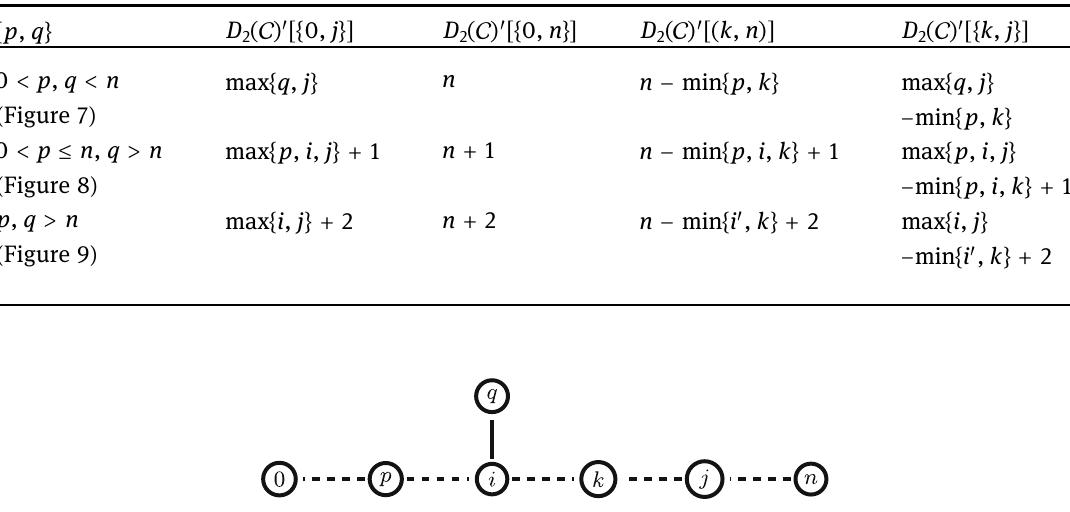
Figure 8: Minimum subgraph of C containing vertices {